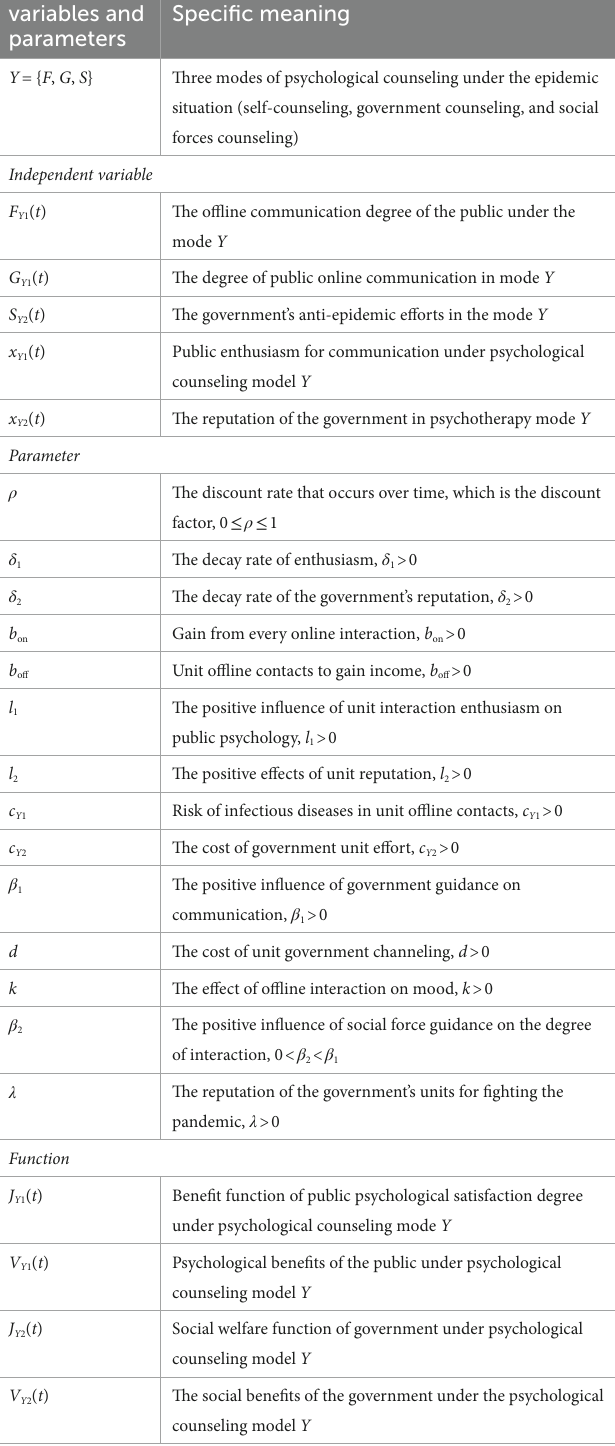
TABLE 1 The main definition of variables and parameters in this